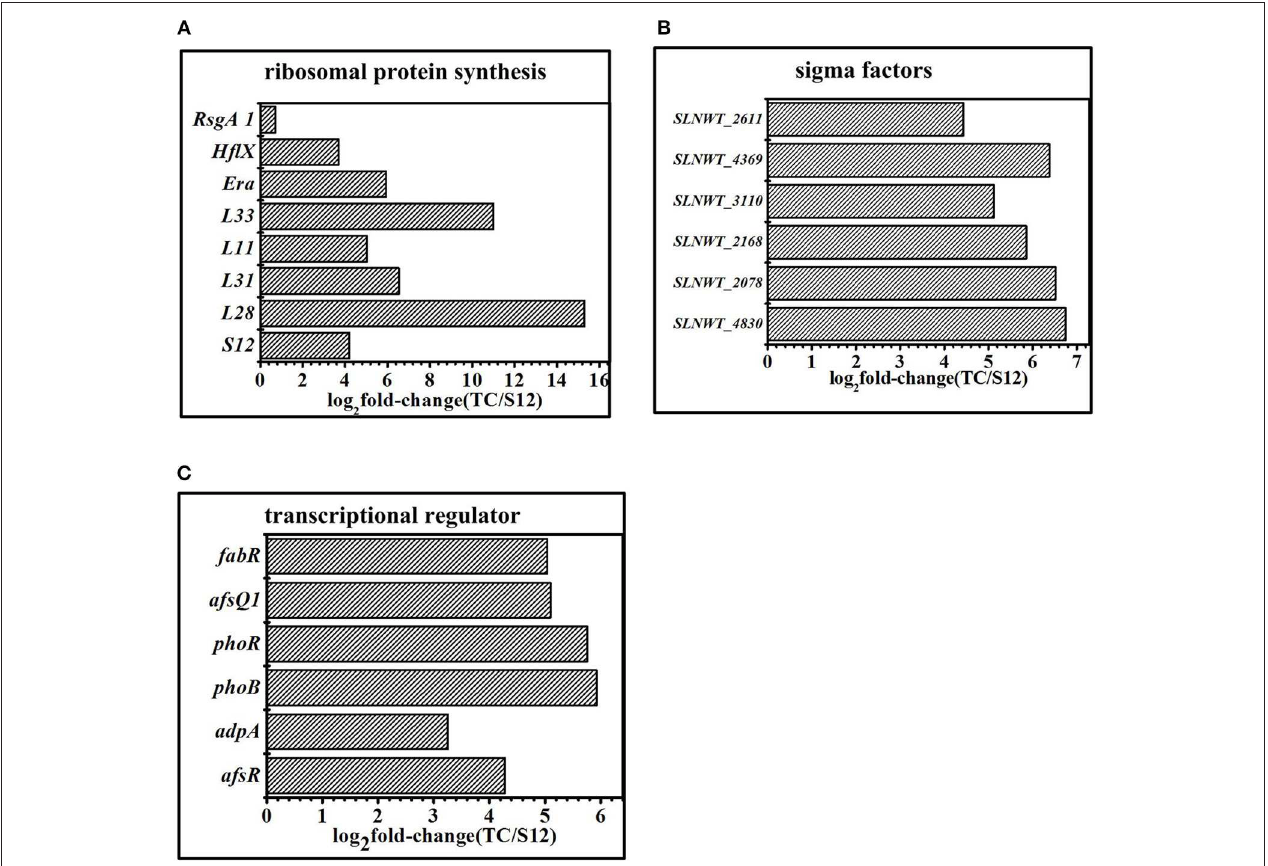
FIGURE 8 | Transcriptomic analysis of the mutants and the original strain S12 at the 5 days in fermentation medium. (A) Expression of genes related to ribosomal protein. (B) Expression of genes related to sigma factors. (C) Expression of genes related to transcriptional regulator. Histograms show the abundance of the transcripts with significant variations ( p -value < 0.05) discussed in the text. Abundance values are shown in log 2 fold-change (TK/S12). For detail genes expression (see Table S7